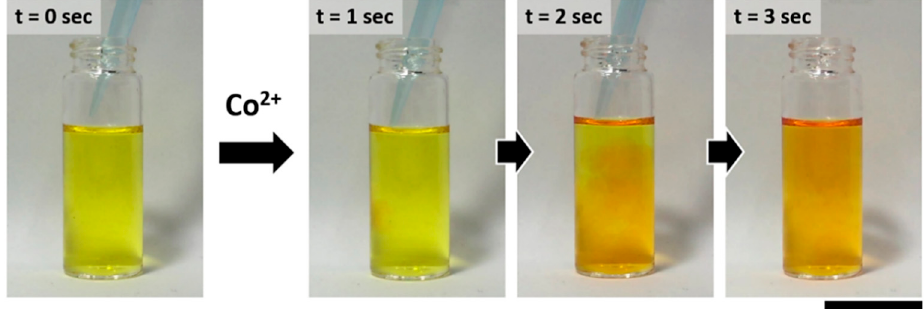
Figure 4. Time sequence images of aqueous CG chemosensor in the presence of cobalt. The concentration of CG chemosensor and cobalt are 7 × 10 − 5 M and 2 ppm, respectively. The scale bar is 3 cm.